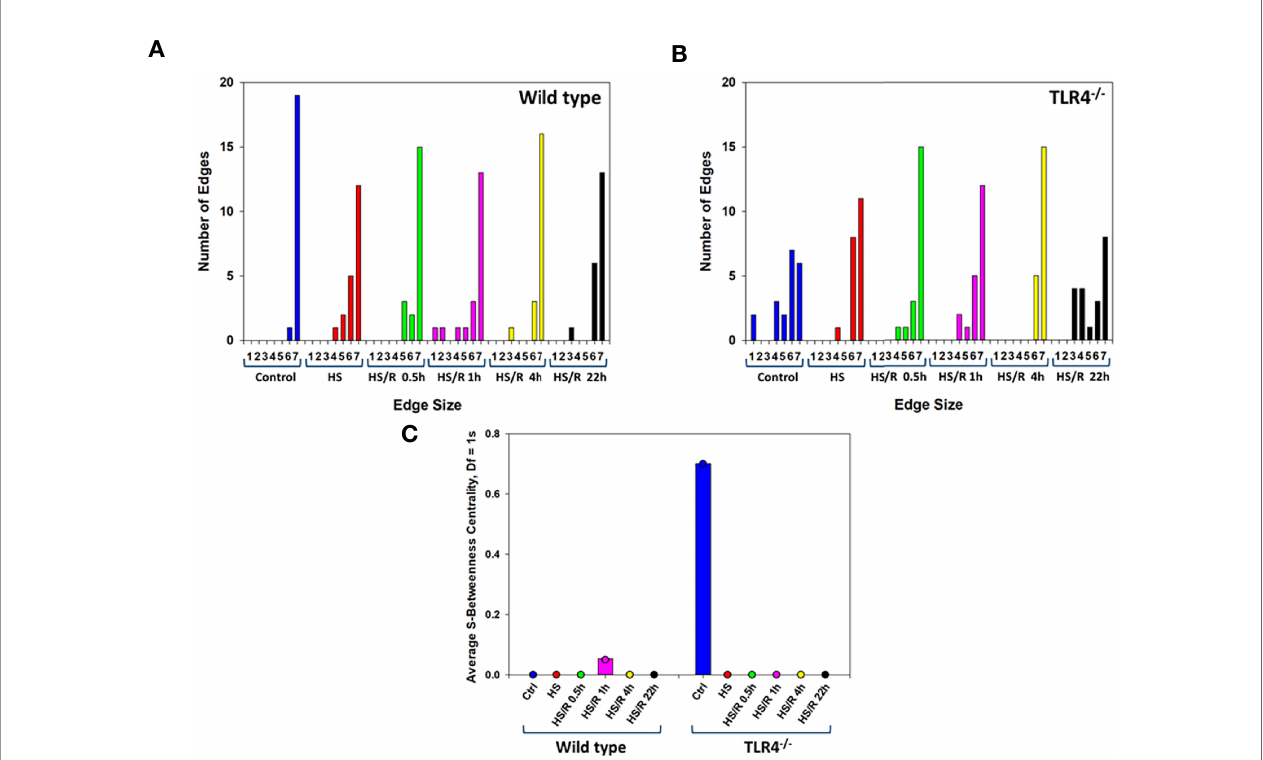
FIGURE 8 | Hypergraph metrics demonstrate differential tissue distribution of in fl ammatory mediators from WT and TLR4 -/- mice. Plasma and tissue samples from heart, lung, liver, gut, spleen, and kidney were collected from Ctrl WT and TLR4 -/- mice or mice subjected to HS and HS/R (0.5-22h) and analyzed using Luminex ™ as described in Materials and Methods. Panels (A, B) show the Hypergraph Edge Distribution analysis in WT and TLR4 -/- mice, respectively. Panel (C) shows the average S-Betweenness Centrality (Df=1) for each hypergraph as indicated in WT and TLR4 -/- mice,